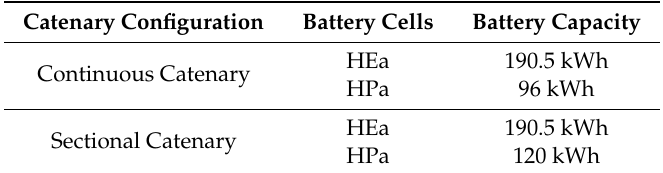
Table 2. Investigated configurations of the catenary power systems and